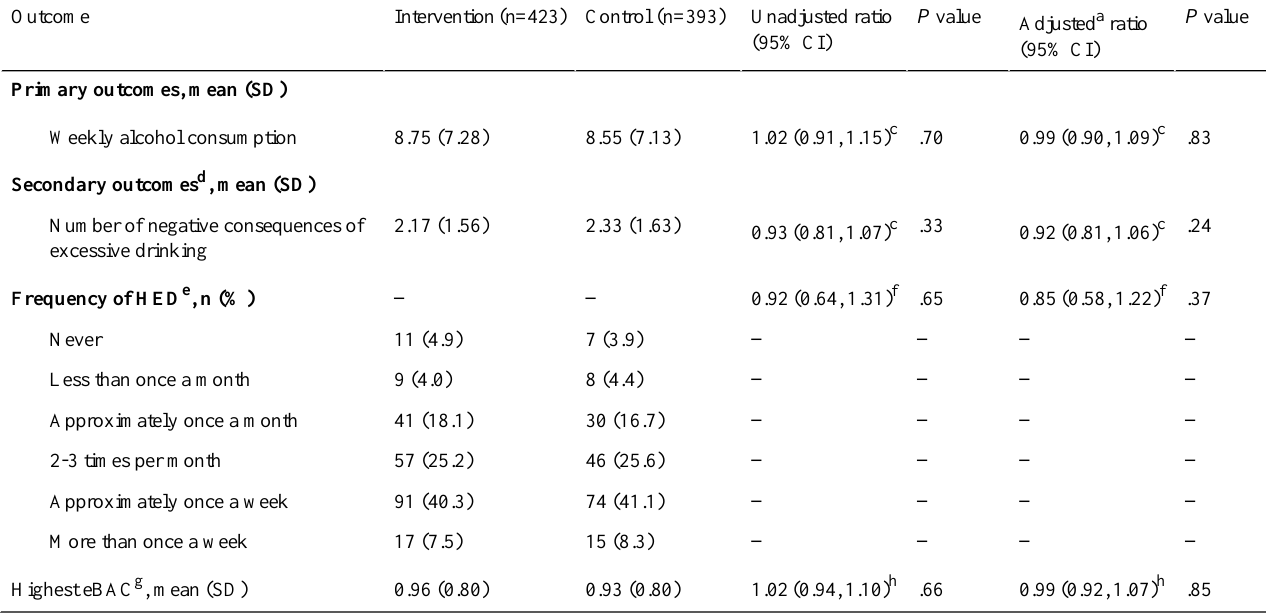
Table 2. Drinking outcomes at follow-up and analysis of treatment effect intervention versus control.